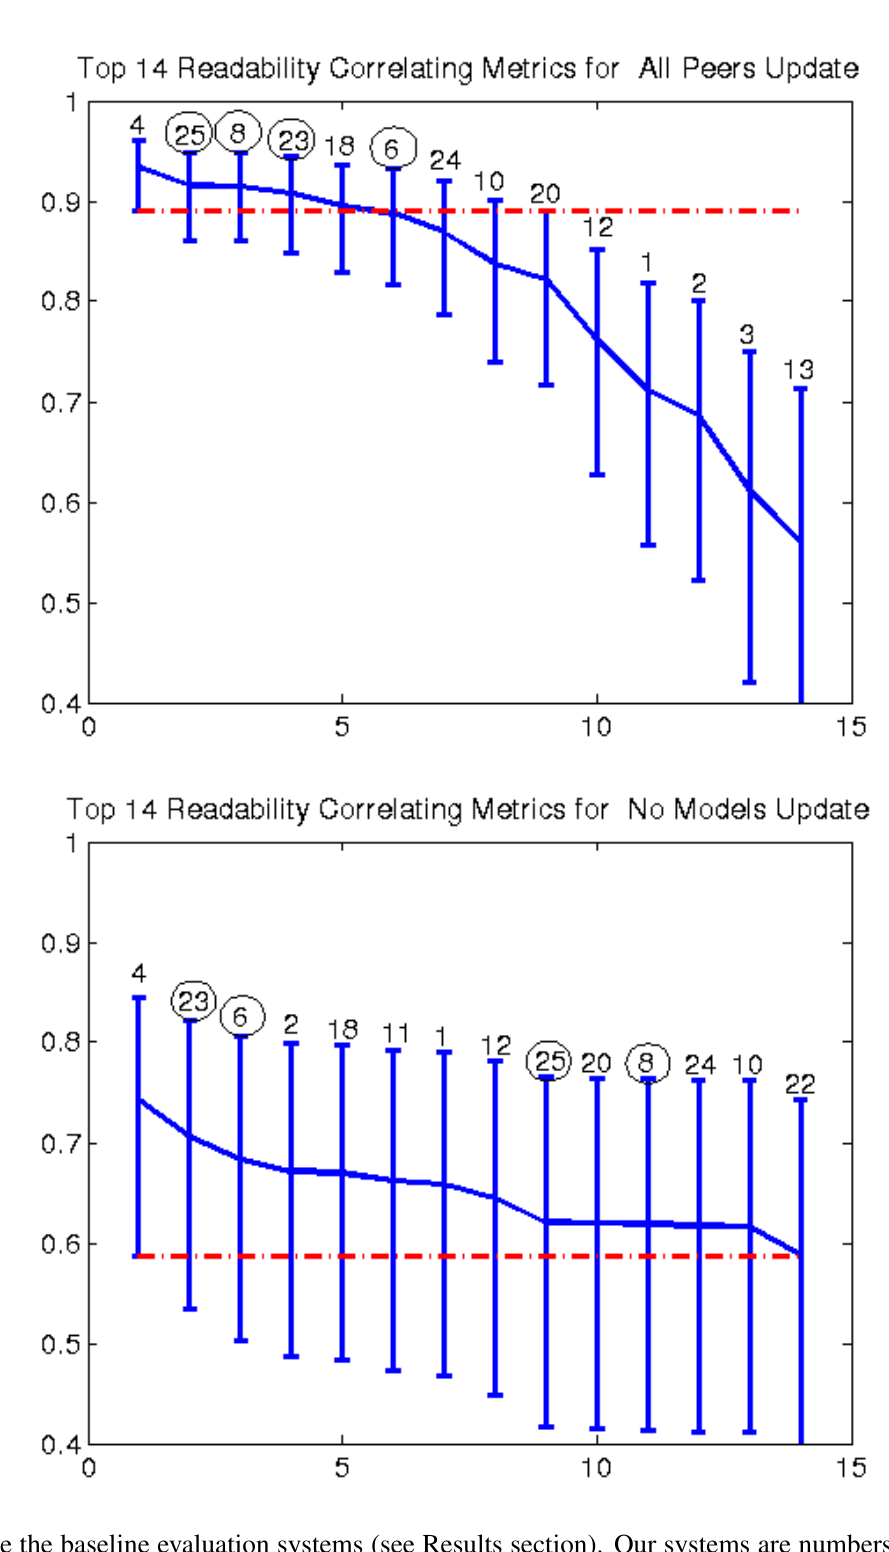
Figure 3. Pearson correlation with readability top 14 AESOP metrics all peers and no models